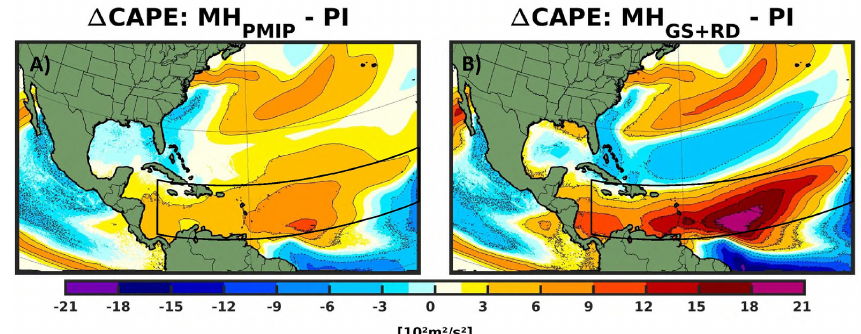
Figure A15. Changes in climatological seasonal CAPE between a saturated boundary layer air parcel and an air parcel that has been isothermally lowered to a reference level (JJASON) for the (a) MH PMIP and (b) MH GS + RD experiments relative to PI. The black box shows the approximate present-day MDR. Only values that are significantly different at the 5% level using a local (grid-point) t test are shaded. The contour lines follow the color-bar scale with different styles (dashed, negative anomalies; solid, positive anomalies); the 0 line is omitted for